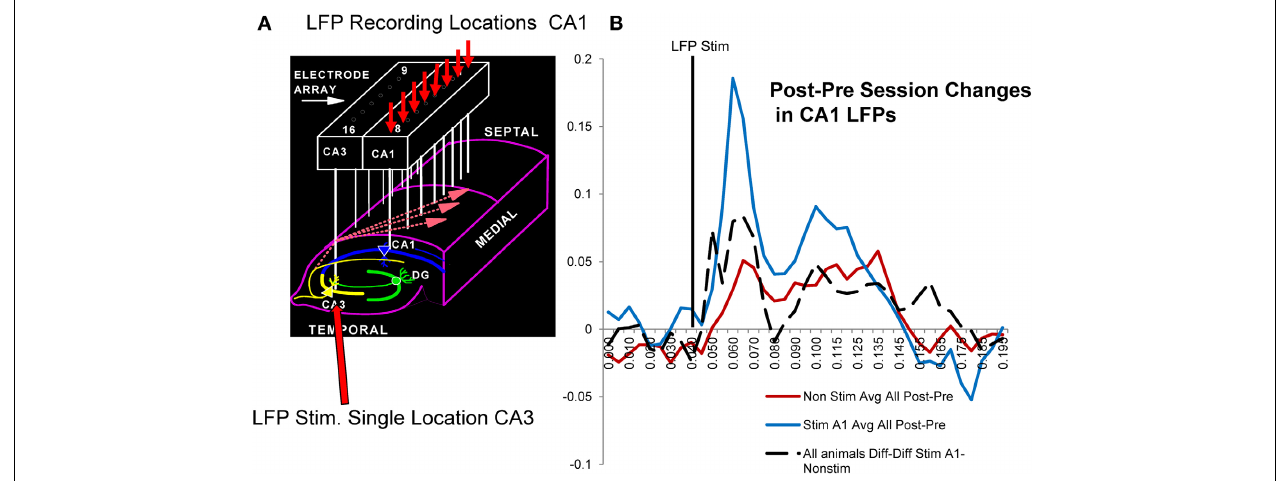
Mean Post-Pre diffs in LFP amplitudes recorded prior to and following non-stimulation sessions for trained animals. Blue: Average Post-Pre diffs in LFP amplitude following sessions in which SR stimulation was delivered to facilitate performance. Positive Post-Pre diffs reflect average voltage changes related to increased CA1 LFP components after the behavioral session relative to voltages elicited by the same CA3 current intensities prior to the session. These Post-Pre diffs for sessions in which SR stimulation facilitated task performance (blue curve) are shown compared to Post-Pre diffs for those sessions in which stimulation was not delivered (red curve). Dotted: Diff-Diff shows average difference between CA1 LFP Post-Pre diffs for SR stim vs. non-stim sessions (Stim-Non-stim) measured in 6 of the Donor rats (all animals